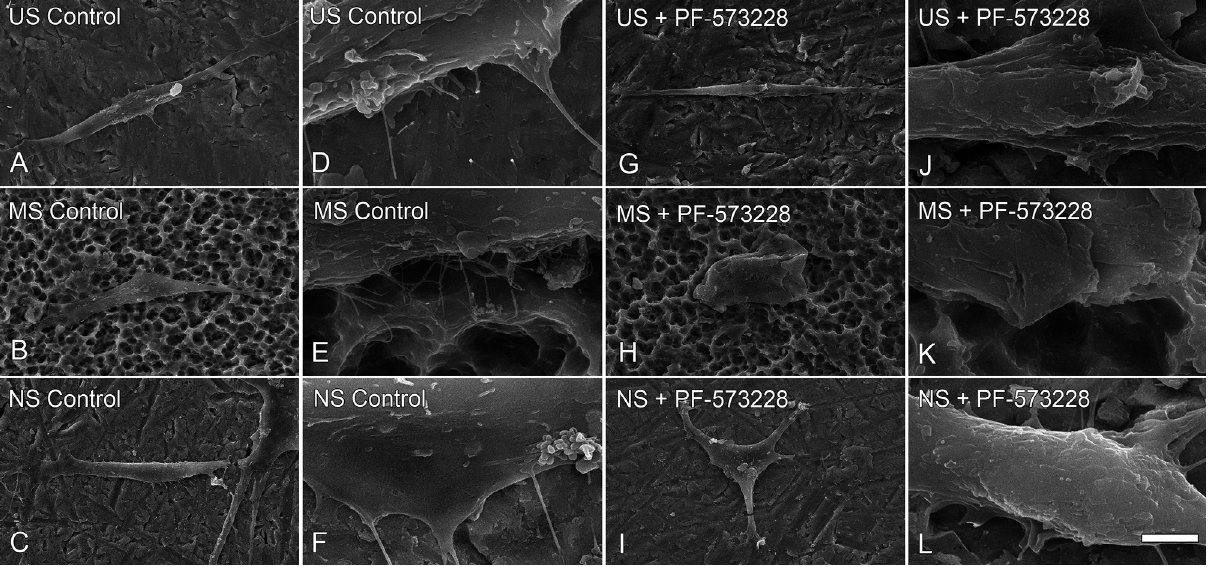
Figure 4- High-resolution scanning electron micrographs of cells cultured on US (A, D, G, J), MS (B, E, H, K), and NS (C, F, I, L) in presence or absence of 0.1 µM PF-573228 at 24 h. Scale bars: A, B, C, G, H, and I=10 µm; D, E, F, J, K, and L=1